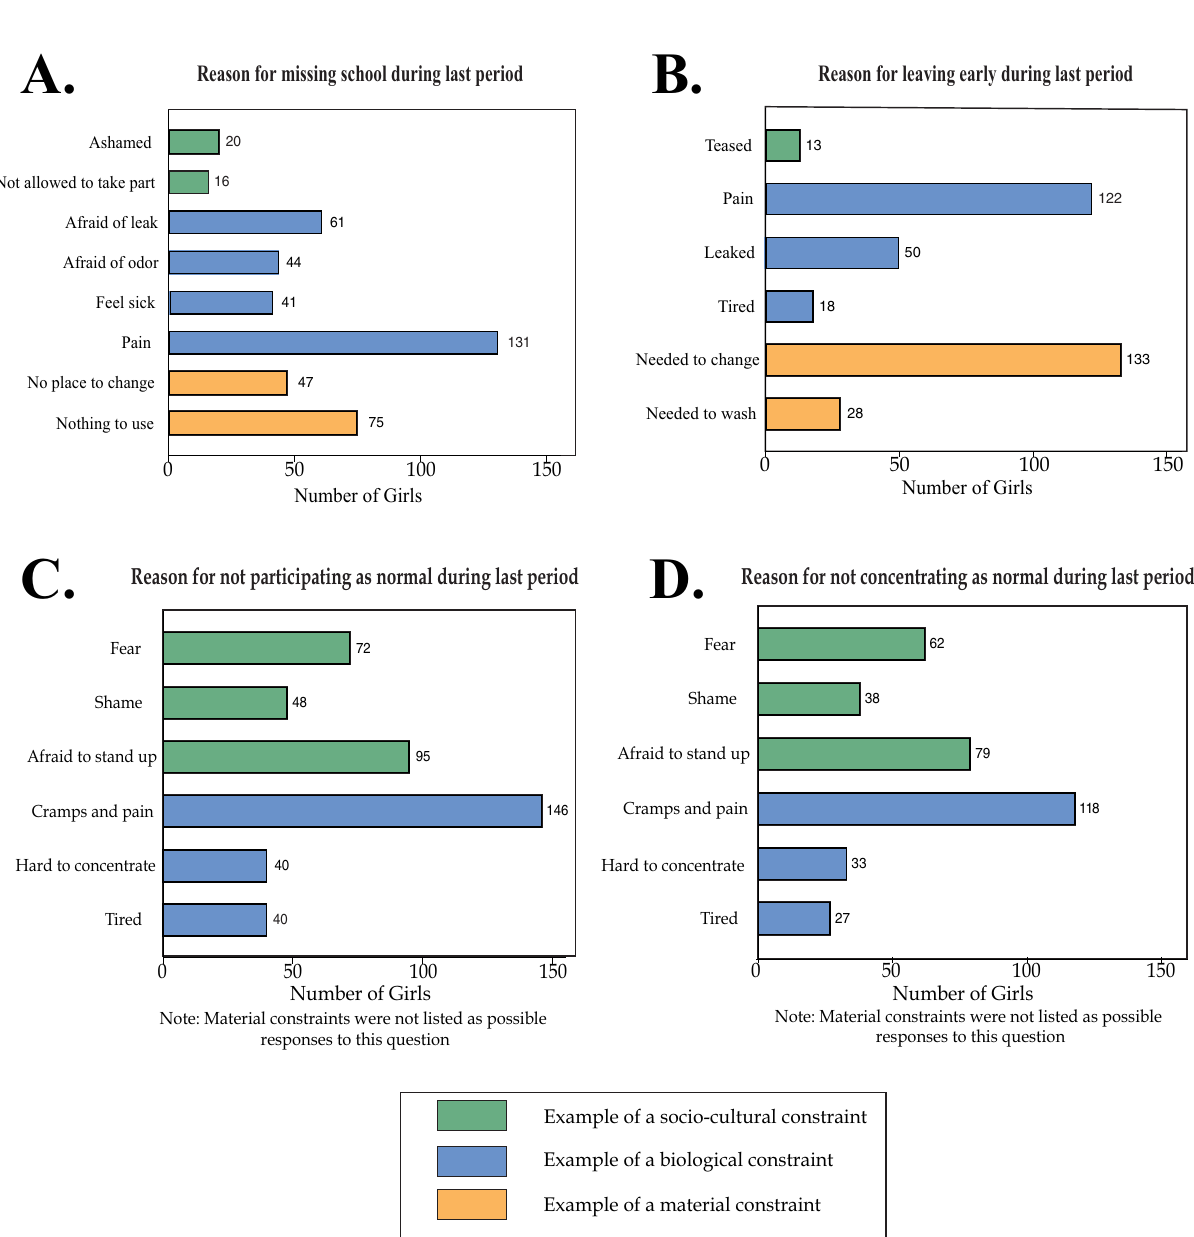
Fig 2. Reasons for absenteeism and reduced participation. The sub-figures indicate the prevalence of each reason, as selected by girls in the sample, for absenteeism or reduced educational outcomes. Please note, the reasons listed here, although coded by constraint type, are not the questions used to build the corresponding constraint index. A) Reason for missing school during last period; B) Reason for leaving early during last period; C) Reason for not participating as normal during last period; D) Reason for not concentrating as normal during last period. Please note the underlying data in this figure was previously published in Benshaul-Tolonen et al. (2020)